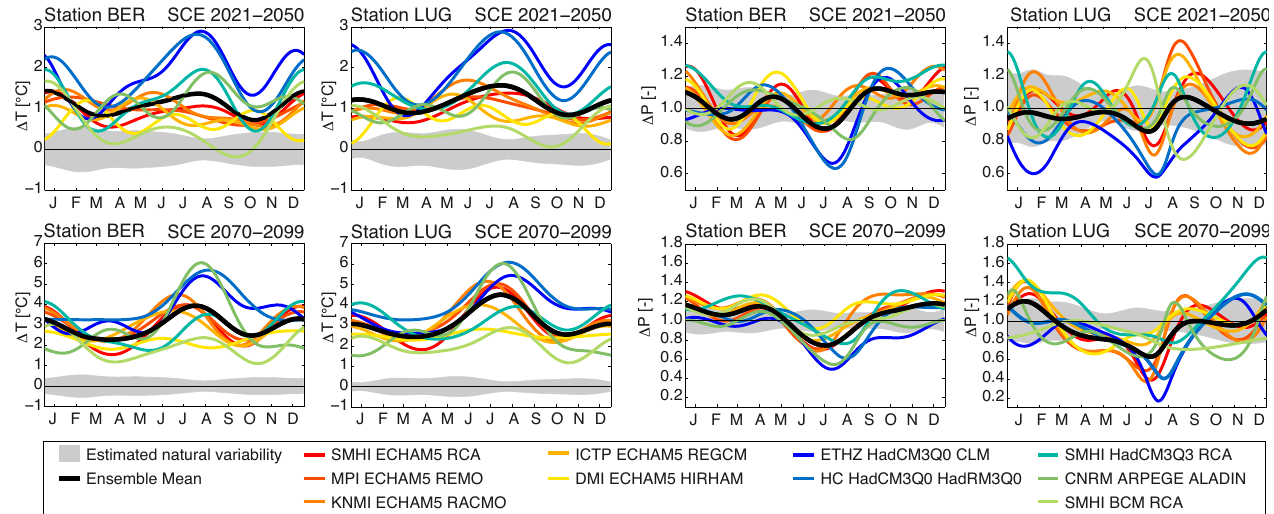
Fig. 8. Annual cycle of 1T (left panel group) and 1P (right panel group) for the scenario period 2021–2050 (top) and 2070–2099 (bottom) at the two exemplary stations BER and LUG. Each of the 10 GCM-RCMs is shown with an individual colour. The ensemble mean is indicated by a black line. The grey band shows the range of the estimated natural variability as ± σ of the resampled 1T s or 1P s at the station site. Note the different scales in upper and lower